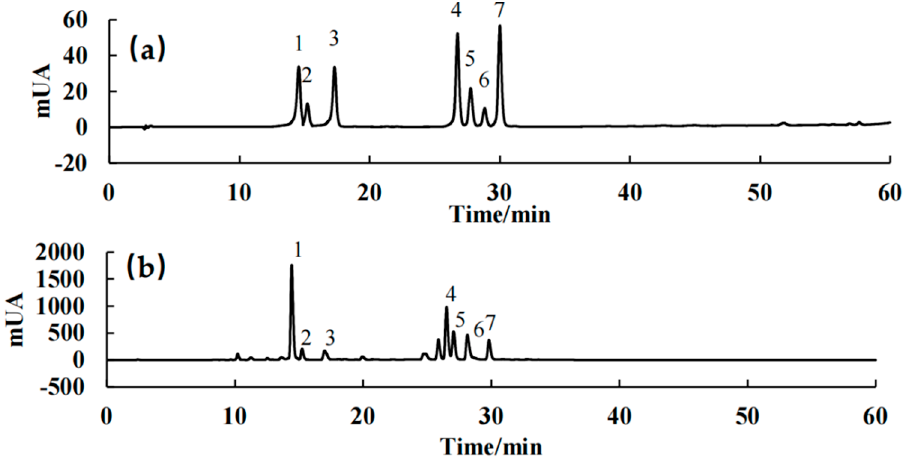
Figure 1. High-performance liquid chromatography (HPLC) profiles of the mixed standards ( a ) and LACCE ( b ). The numbers in the profiles represent the following: 1. Syringin, 2. Chlorogenic acid, 3.